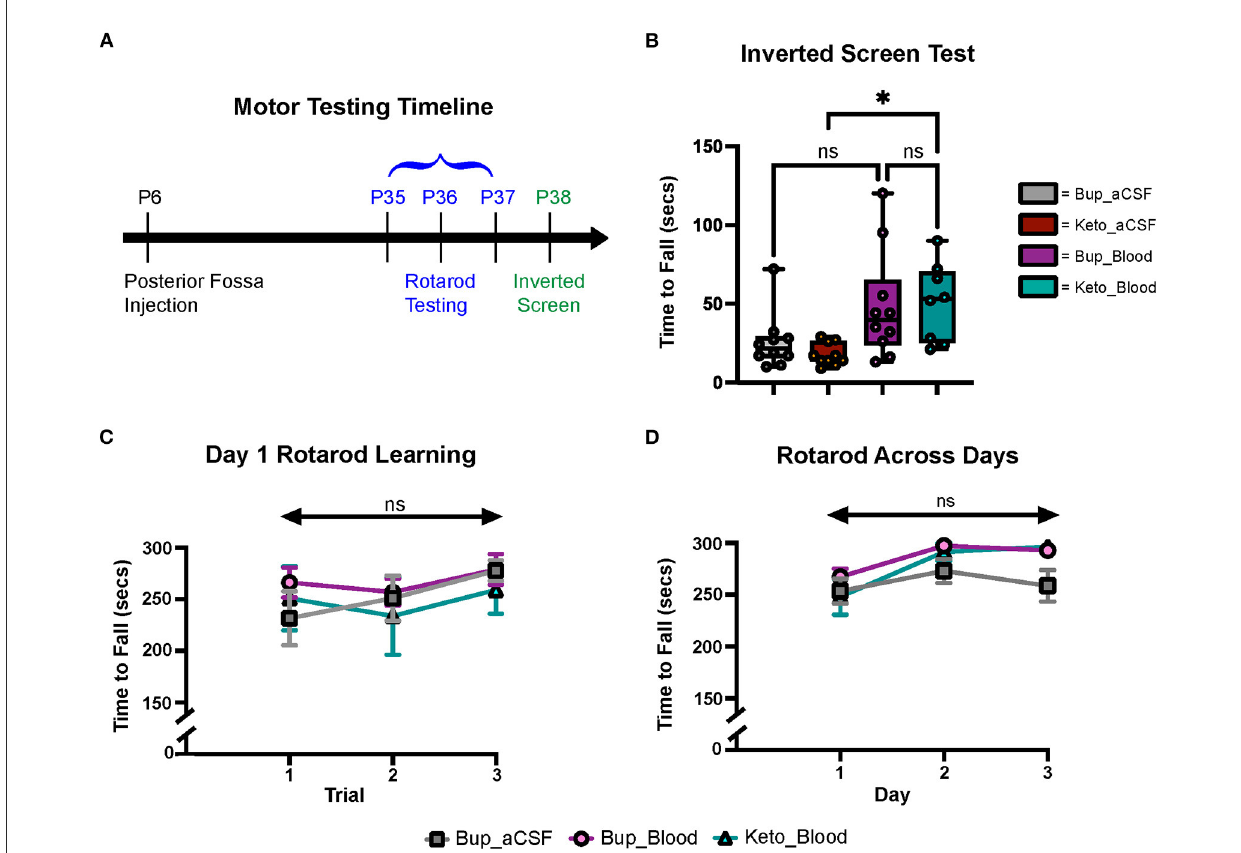
FIGURE3 CHI did not result in significant motor learning/coordination deficits. (A ) Schematic of motor testing assays and timeline. (B) Quantification of time to fall for the inverted screen test for all groups ( N = 10*) † . (C) Quantification of the time to fall for Day 1 of Rotarod training for all groups ( N = 10*) ‡ . (D) Quantification of the time to fall for Days 1-3 of Rotarod training for all groups ( N = 10*) ‡ . Data are presented as mean ± SEM (B) or SEM with minimum and maximum values (C, D) . N = number of animals per group included for analysis. *Keto_Blood group with N = 8. † Significance defined as p < 0.05 by one-way ANOVA with Tukey’s post-test. ‡ Significance defined as p < 0.05 by two-way ANOVA with Tukey’s